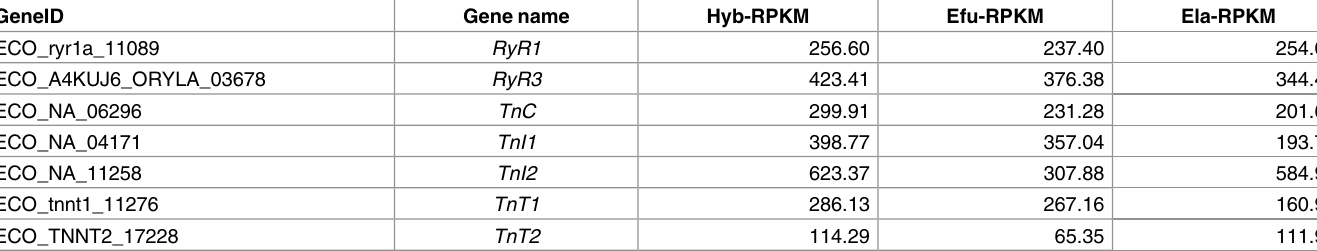
Table 3. RPKMs of Ca2+ regulating genes and downstream troponins in the three